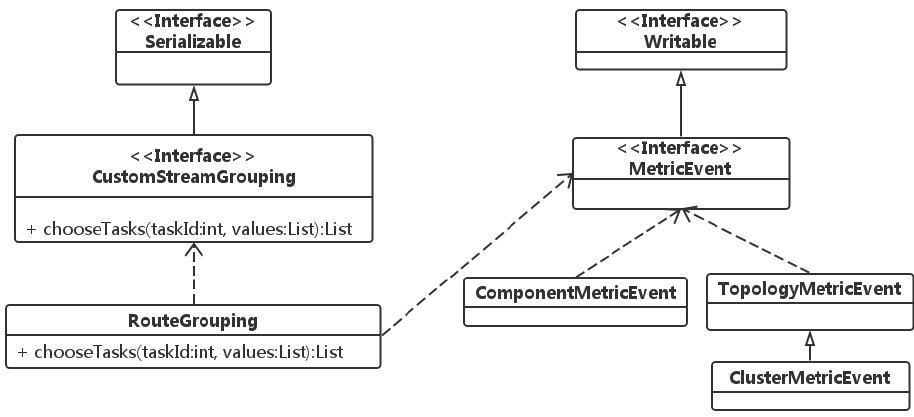
Figure 6. Core classes of tuple